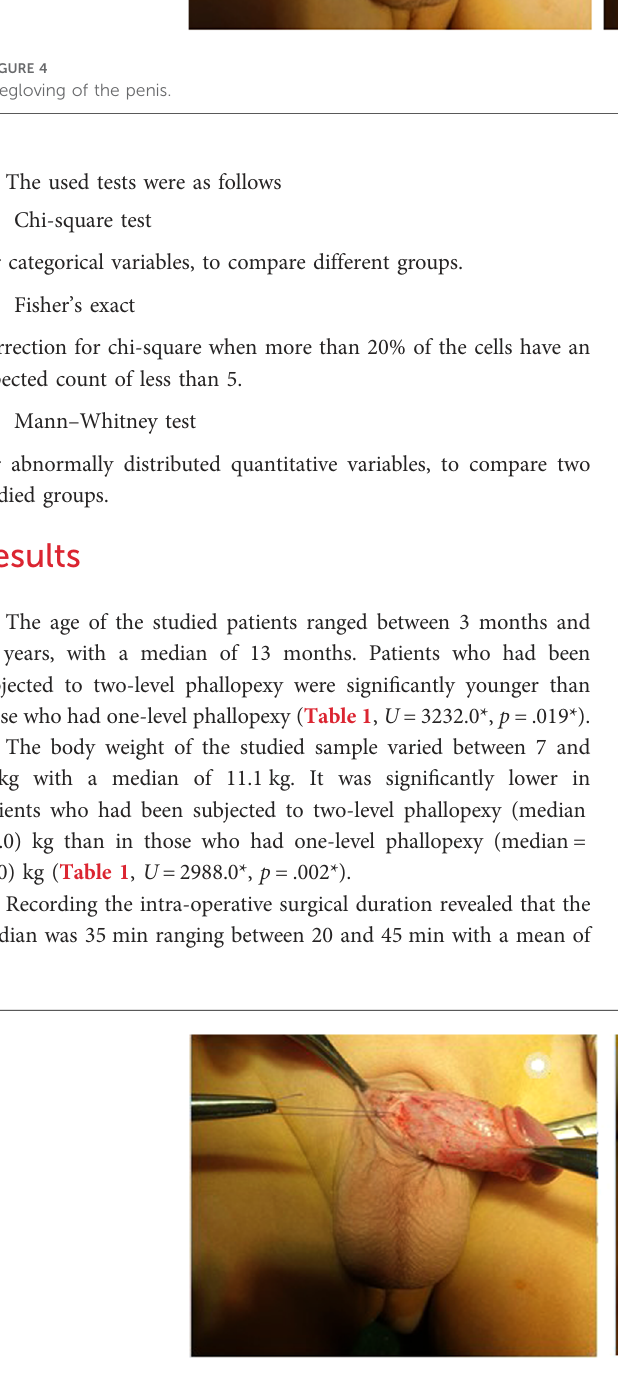
FIGURE 5 Penile fi xation